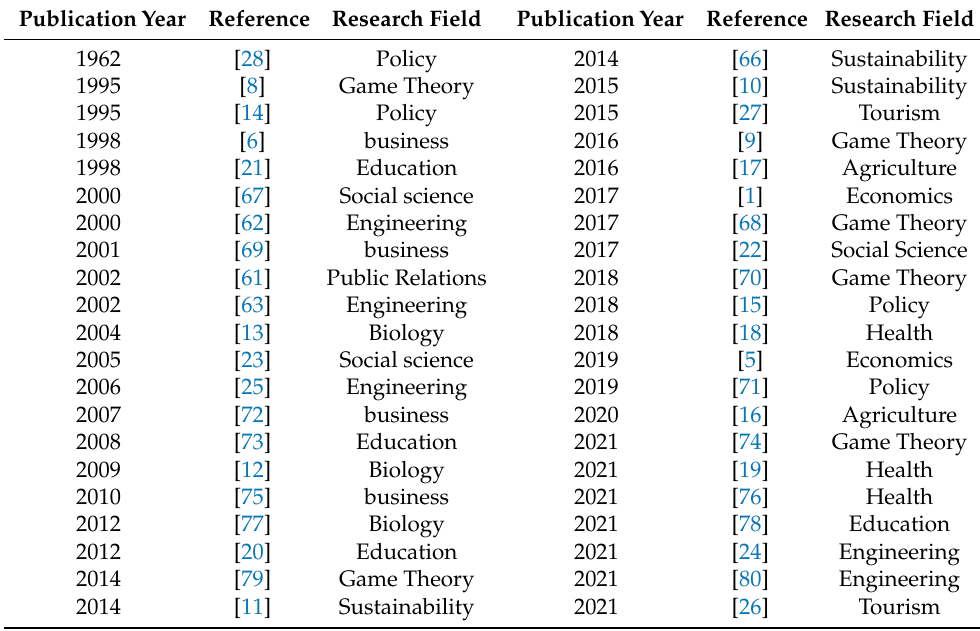
Table 1. Some examples of win–win related